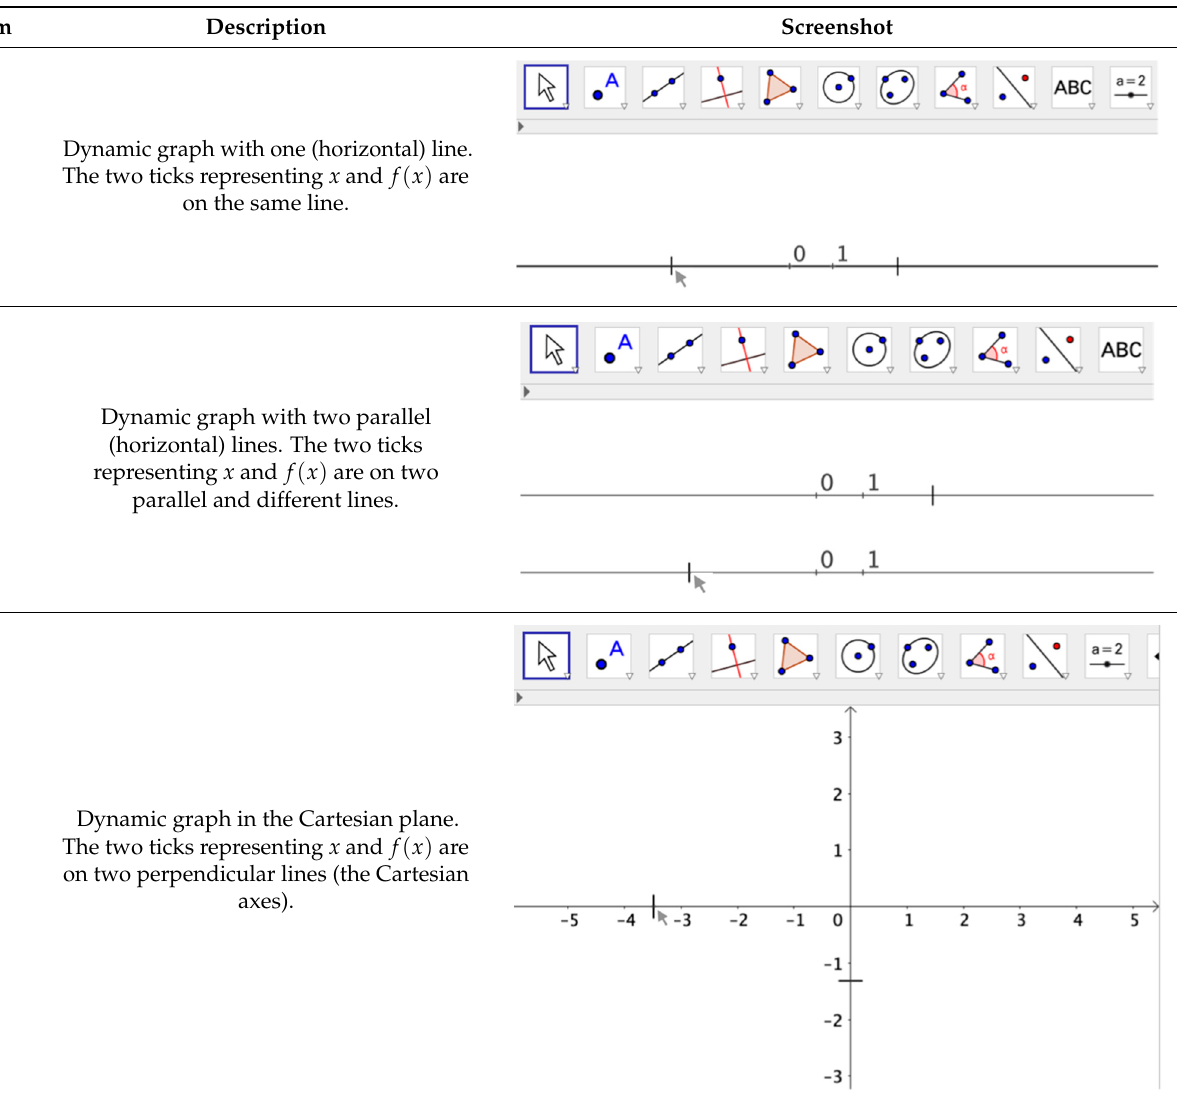
Table 1. The graphs used in the activities. SGc is the well-known Cartesian graph. DGp, DGpp, and DGc are dynamic graphs where x and 𝑓(𝑥) are represented by ticks. The tick representing x is draggable (as indicated by the mouse cursor in the screenshots) and its movement causes the movement of the tick representing 𝑓(𝑥) , according to the functional dependency. Acronym Description Screenshot